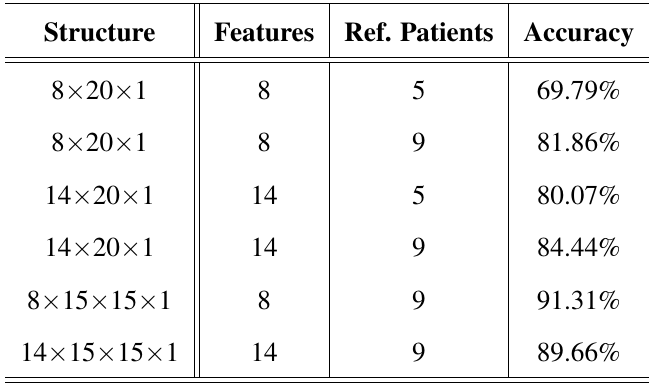
Table 1. Comparison of neural network setups.